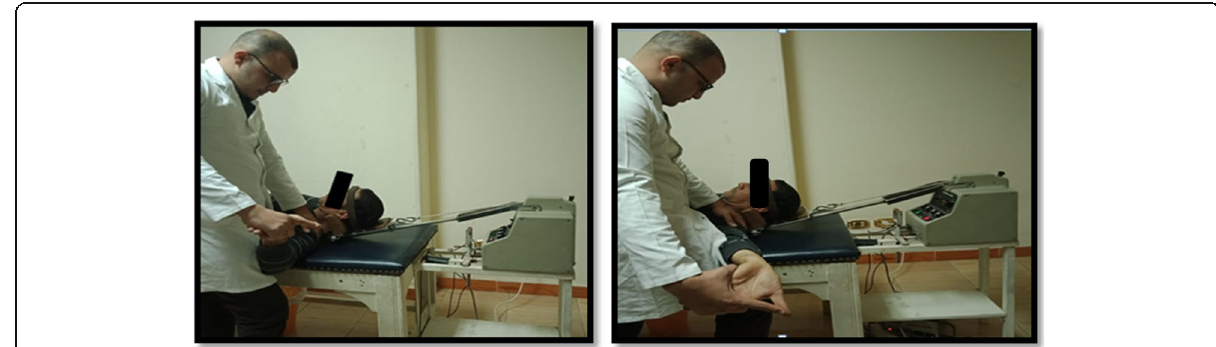
Fig. 2 Intermittent cervical traction combined with median nerve mobilization